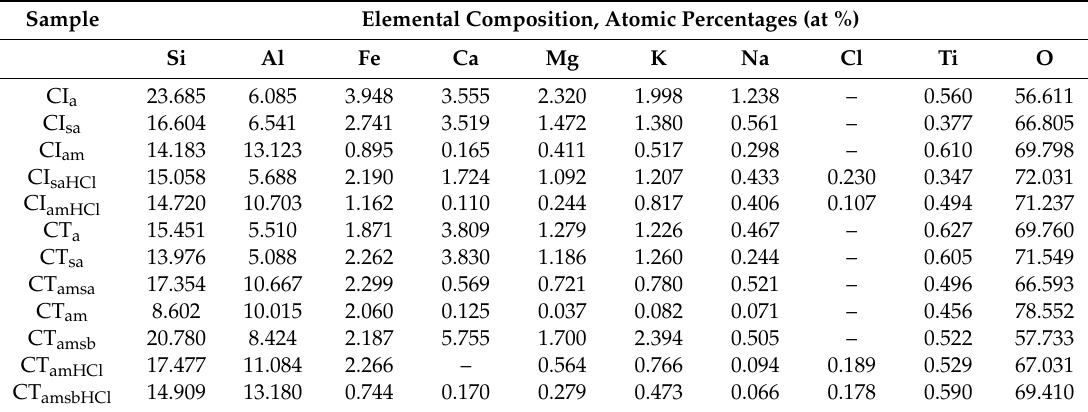
Table 1. Chemical elemental composition of the studied